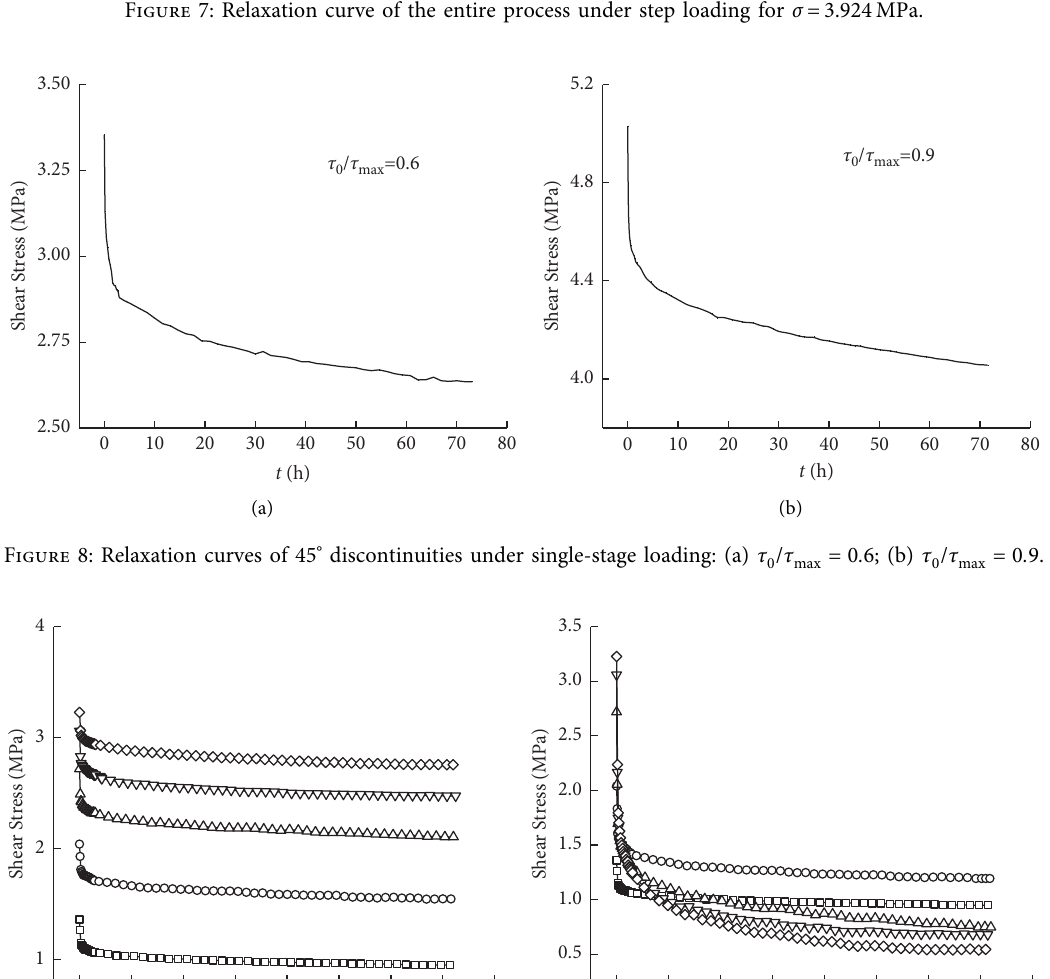
� 3.924MPa; (b) after su- 0